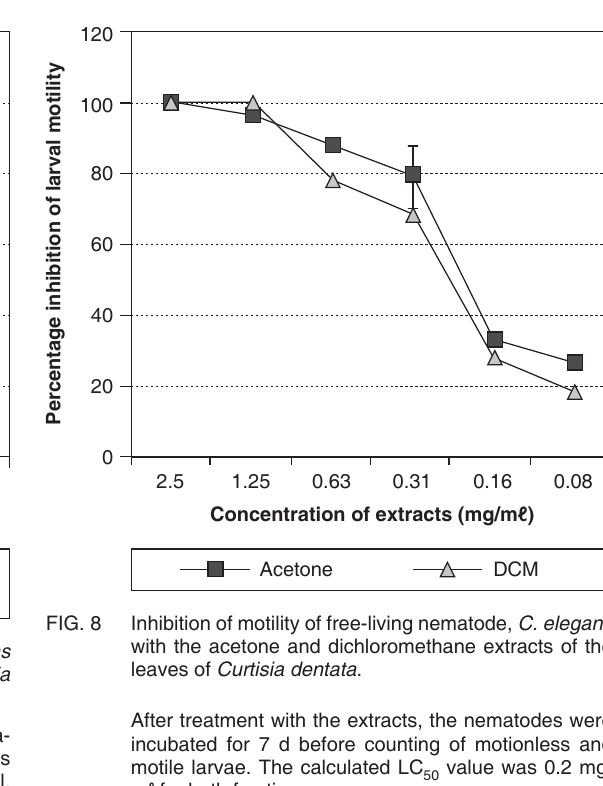
values were estimated at 120 μ g/m ℓ for lupeol, LC 50 140 μ g/m ℓ for betulinic acid and 180 μ g/m ℓ for ursolic